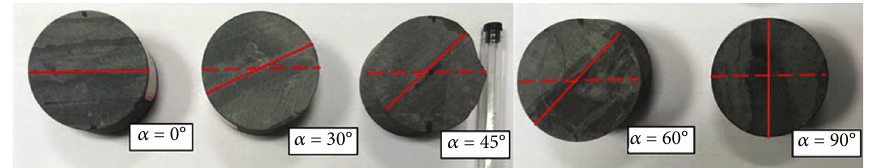
Figure 2: Schematic diagram of Brazilian splitting samples of carbonaceous slate with di ff erent bedding inclination angles.